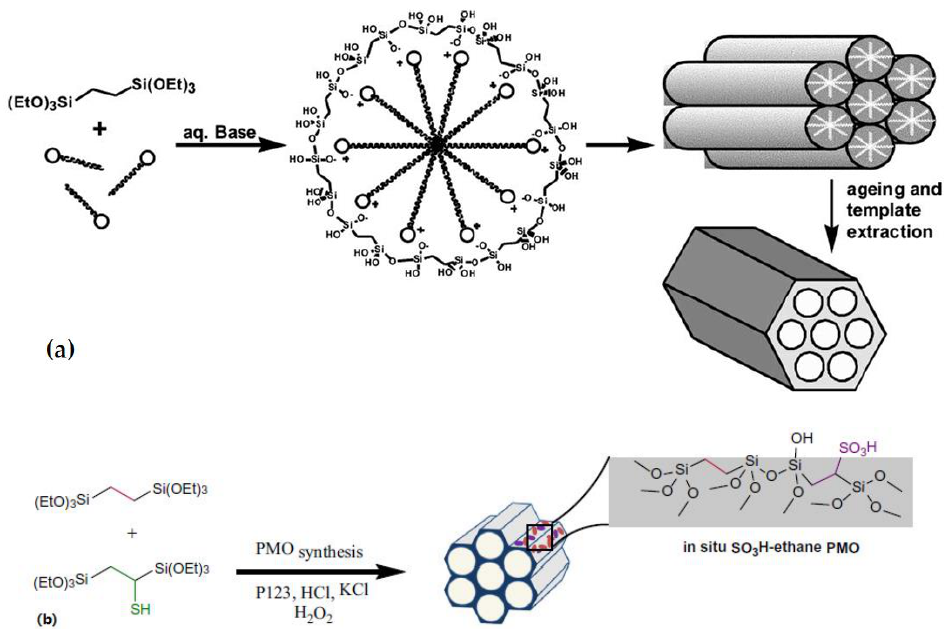
Figure 1. Transmission electron micrograph and electron diffraction pattern (inset) of periodic mesoporous organosilica (PMO) with two-dimensional (2D) hexagonal symmetry. Reprinted with permission from Reference [41]; copyright (1999) American Chemical